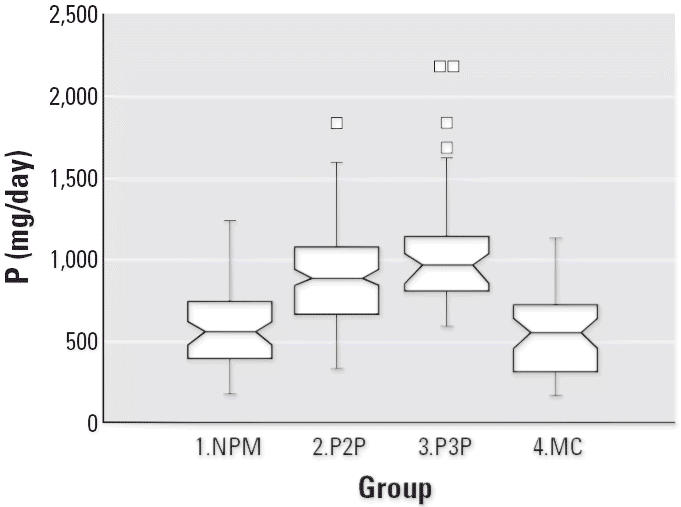
Notched box plot for descriptive statistical data showing daily intakes
of P from 6-day duplicate diets. The recommended daily intake for such
females is 1,200 mg P (National Research Council 1989).